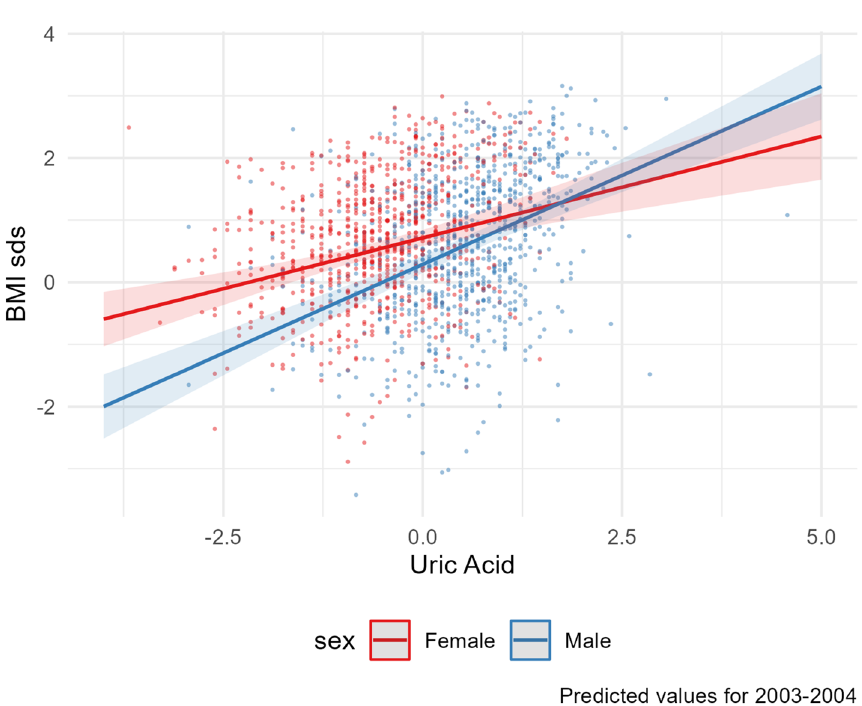
Figure 5. Scatter plot of the association between zBMI and uric acid in the 2003–2004 survey dataset: multivariable analysis including sex*uric acid as interaction